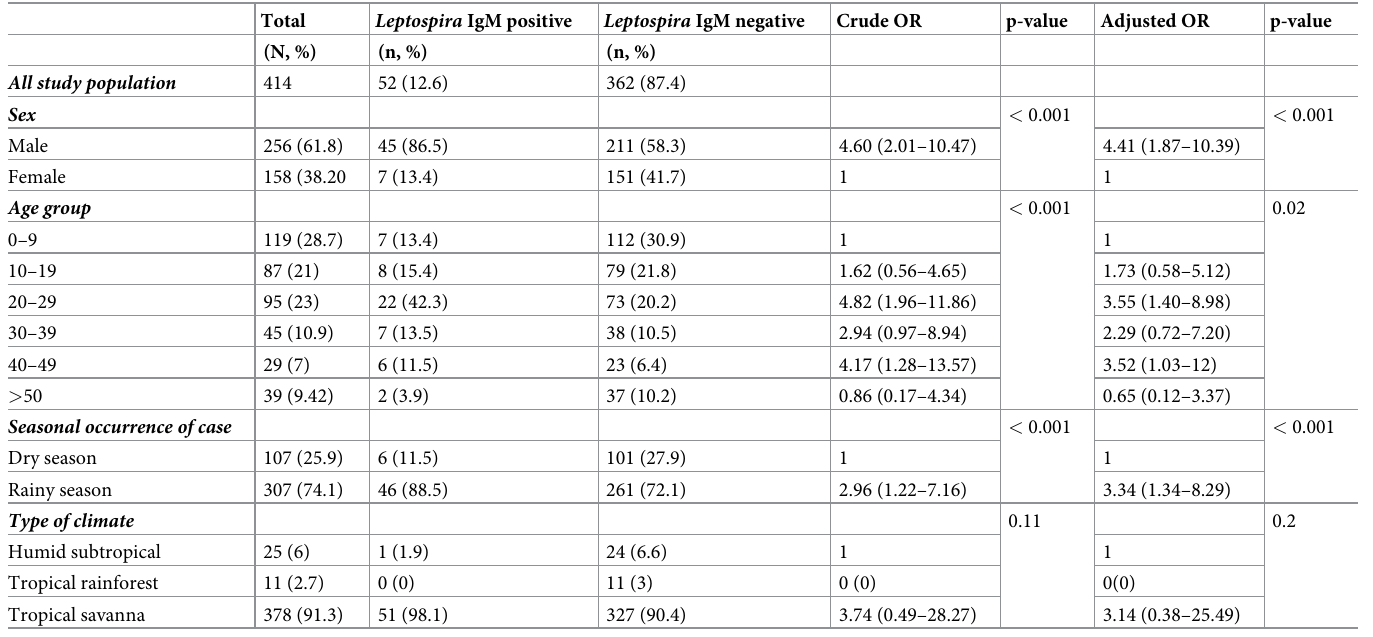
Table 2. Socio-demographic, climate characteristics, and risk factors associated with positive leptospiral serology in urban areas of the DR. Congo (2017–2018).